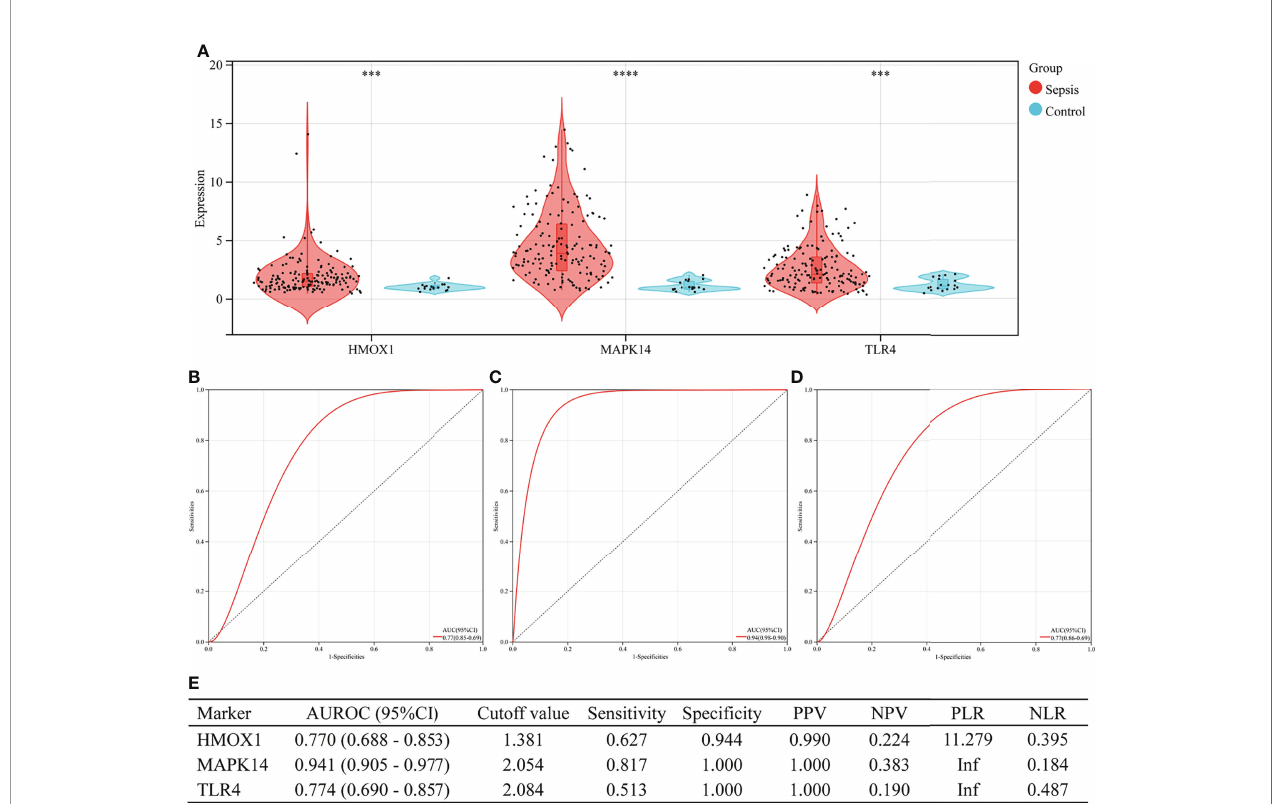
FIGURE 7 | The performance of hub genes to diagnose sepsis in the GSE13904 validation set. (A) Expression difference of three hub genes in sepsis and control groups. (B) Receiver operating characteristic (ROC) curve of HMOX1 gene diagnosis of sepsis. (C) ROC curve of MAPK14 gene diagnosis of sepsis. (D) ROC curve of TLR4 gene diagnosis of sepsis. (E) Diagnostic value of three hub genes for differentiating between sepsis and control groups. PPV, positive predictive value; NPV, negative predictive value; PLR, positive likelihood ratio; NLR, negative likelihood ratio; AUROC, area under the receiver operating characteristics curve; CI, con fi dence interval; ***P < 0.001, ****P <